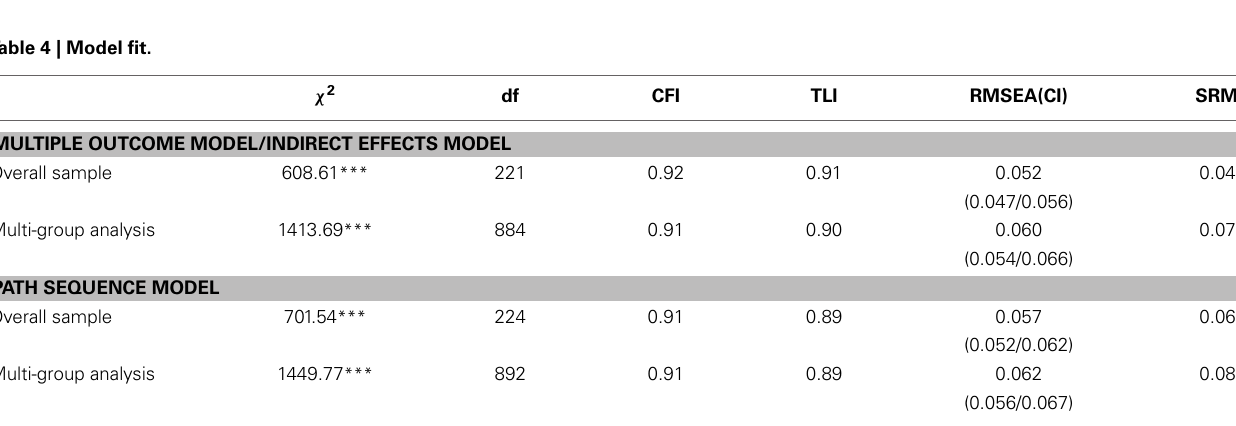
FIGURE 3 | Indirect effects models including total and direct effects in the four cultural samples. † p < 0 . 10, ∗ p < 0 . 05, ∗∗ p < 0 . 01, ∗∗∗ p < 0 . 001.